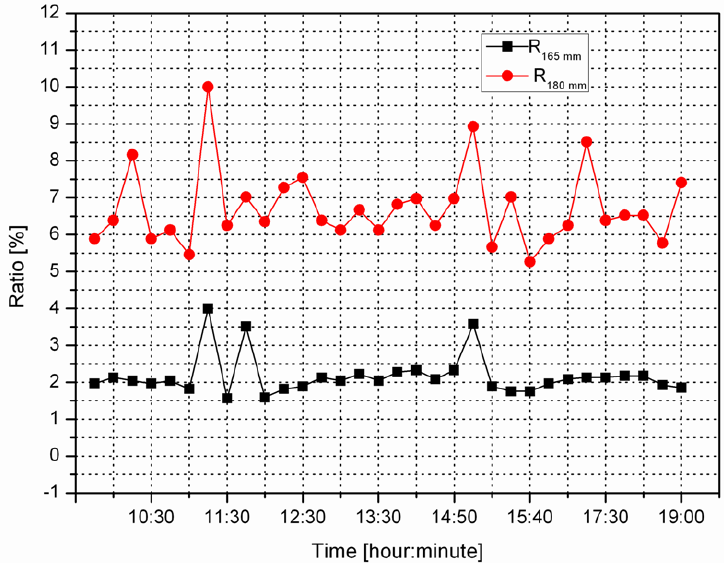
Figure 11. Thermal efficiency comparison of the BHE with three different drillholes on August 07, 2009. The thermal comparison ratio is presented for block II and block III as compared to block